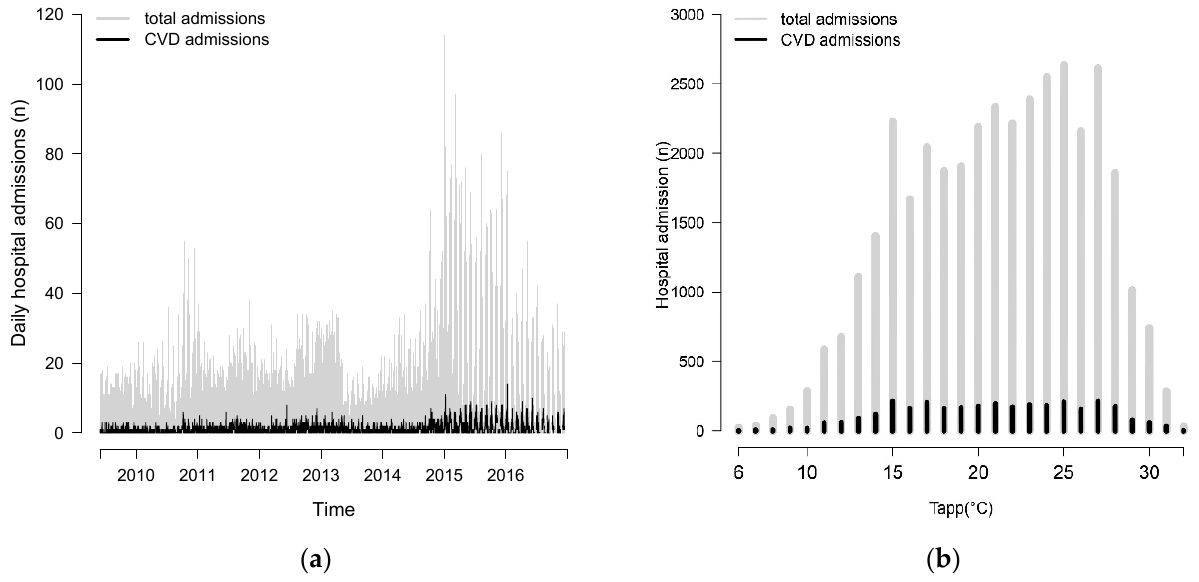
Figure 2. ( a ) The distribution of daily total (N = 37,090) and CVD (N = 3124) hospital admission counts during the study period, and ( b ) the distribution of total and CVD hospital admission counts in relation to T app